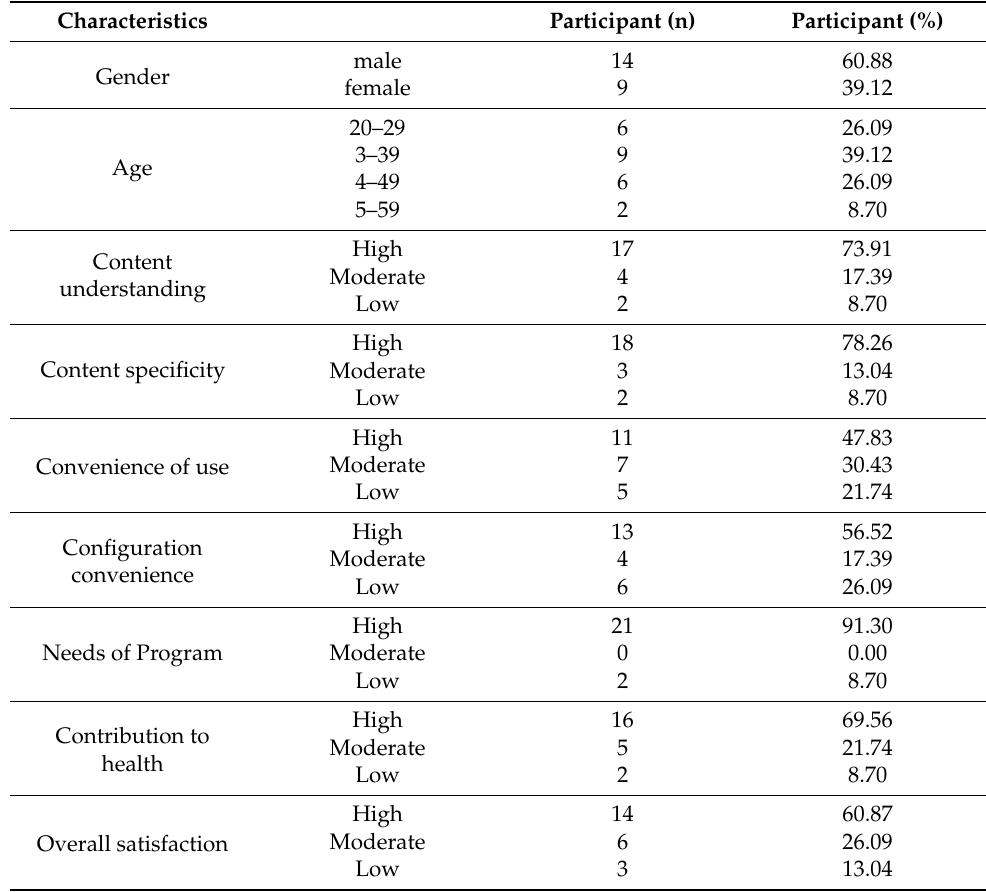
Table 2. Characteristics of participants and the effectiveness of the chatbot program for follow-up